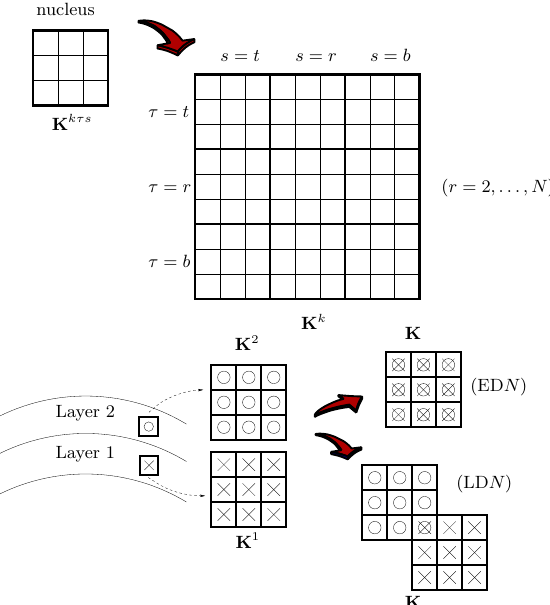
Figure 2: Graphical representation of the expansion and assembly procedure to transform the discrete fundamental nuclei of the formula- tion into the final discrete matrices governing the problem. Example of a curved panel with two